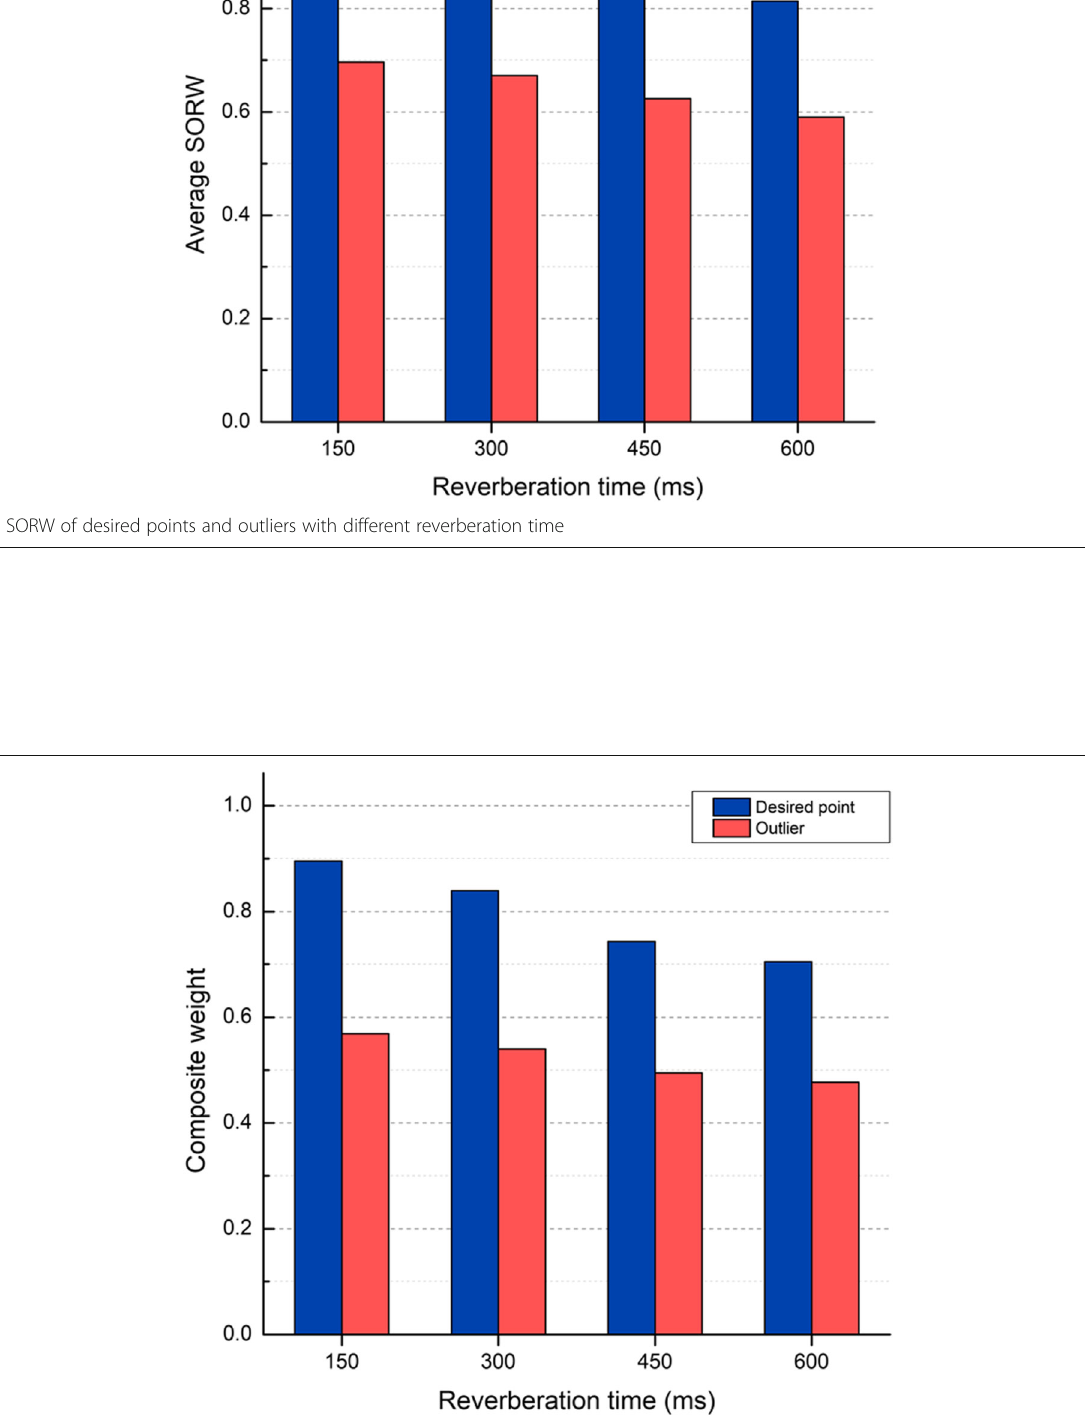
Fig. 6 Composite weight of desired points and outliers with different reverberation time